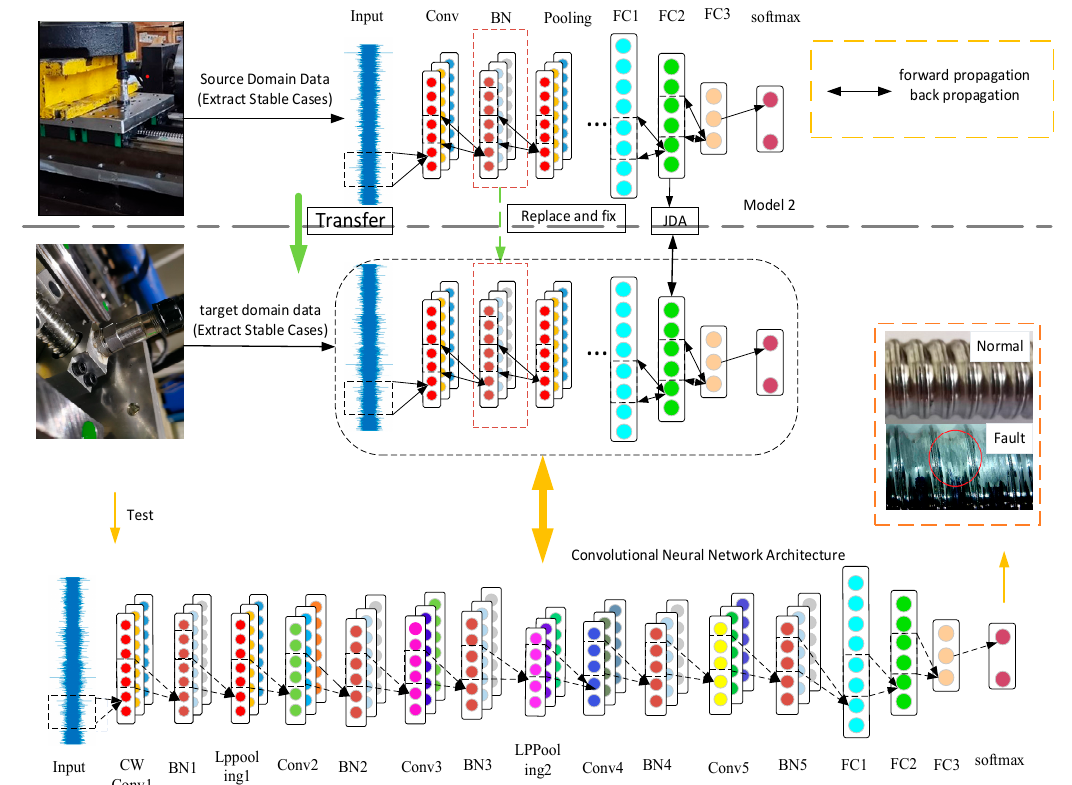
Figure 3. Transfer of fault diagnosis knowledge between different locations.